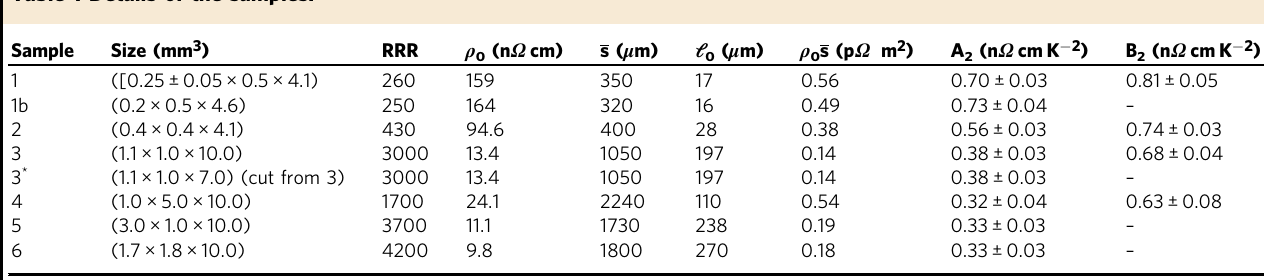
– ffiffiffiffiffiffiffiffiffiffiffiffiffiffiffiffiffiffiffiffiffiffiffiffiffiffiffiffiffiffiffiffiffiffi p Sbcrystalsusedinthisstudywereorientedalongthebisectrixcrystallographicaxis. s ¼ width ´ thickness representstheaveragediameterof theconductingcross-section.Theresidualresistivityratio is de fi ned as RRR ¼ ρ 300 K ρ . The carrier mean free path ℓ 0 was calculated from the residual resistivity and the expression for Drude conductivity assuming three spherical hole and three spherical electron 0 pockets. This is a crude and conservative estimation, because the mean free path of hole-like and electron-like carriers residing in different valleys is likely to differ (See the Supplementary Note 2 for more details). Also given is the product of ρ 0 s , a measure of crystalline perfection (Supplementary Note 2). The last two columns give the electrical ( A 2 ) and thermal ( B 2 ) T 2 -resistivities